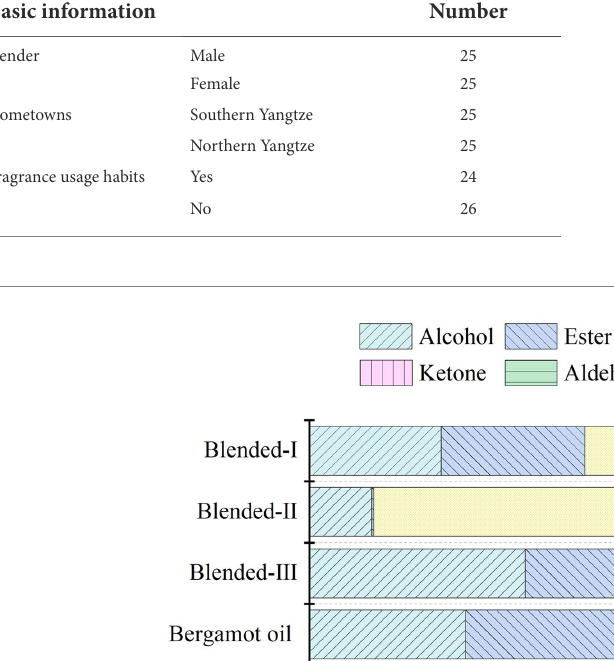
TABLE 1 Basic information of participants.